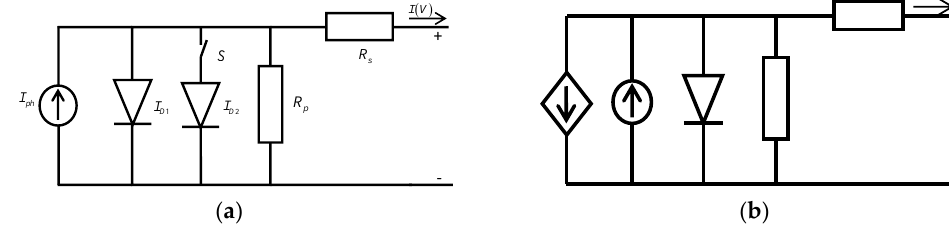
Figure 1. Equivalent circuit solar cell model: ( a ) single and double diode, ( b ) flexible hydrogenated amorphous silicon a-Si:H.